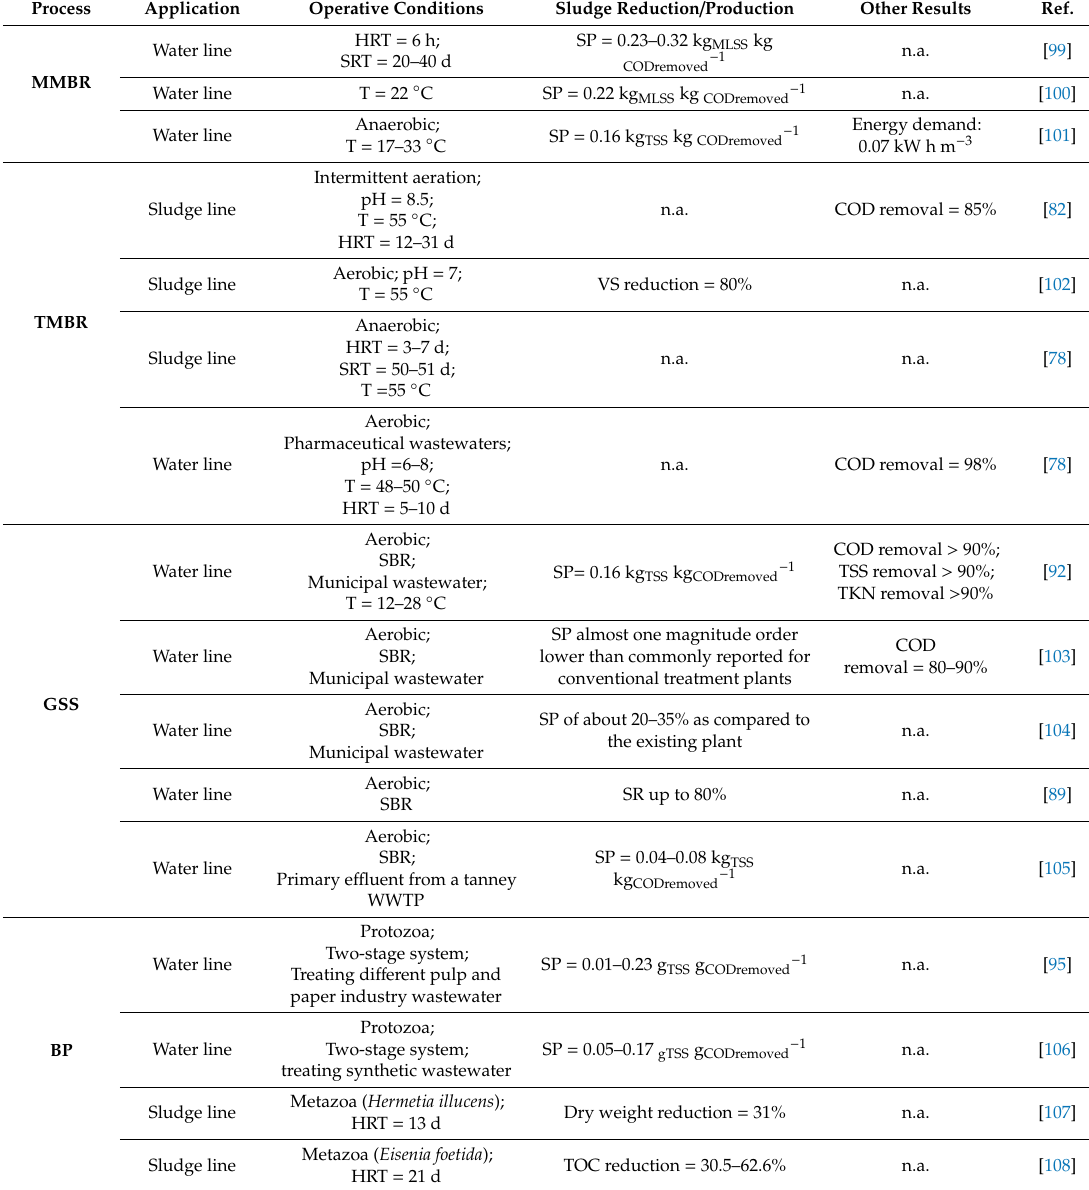
Table 2. Several applications of biological